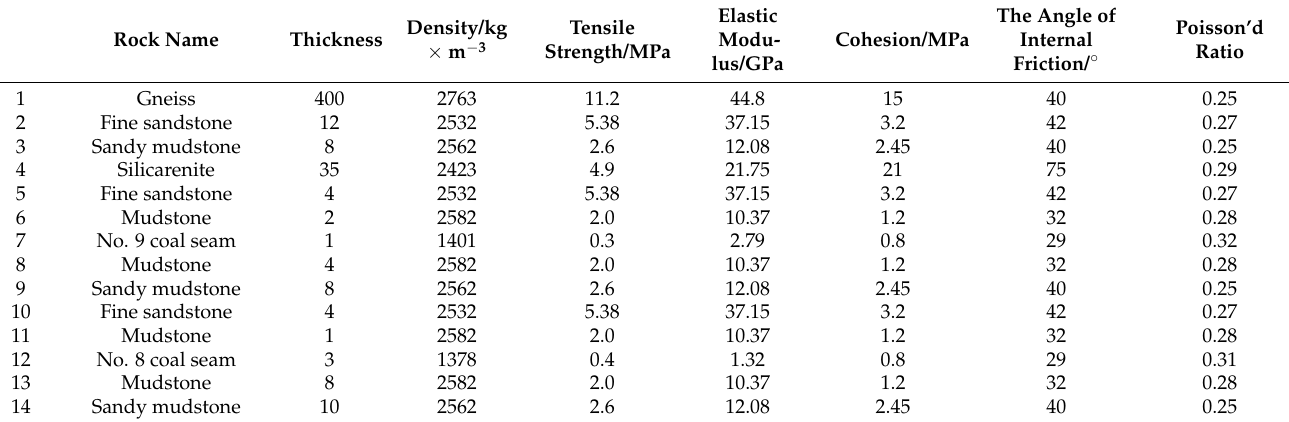
Figure 5. Overall numerical model and roadway-concentrated areas diagram. Table 1. Numerical model of rock physical and mechanical parameters table.